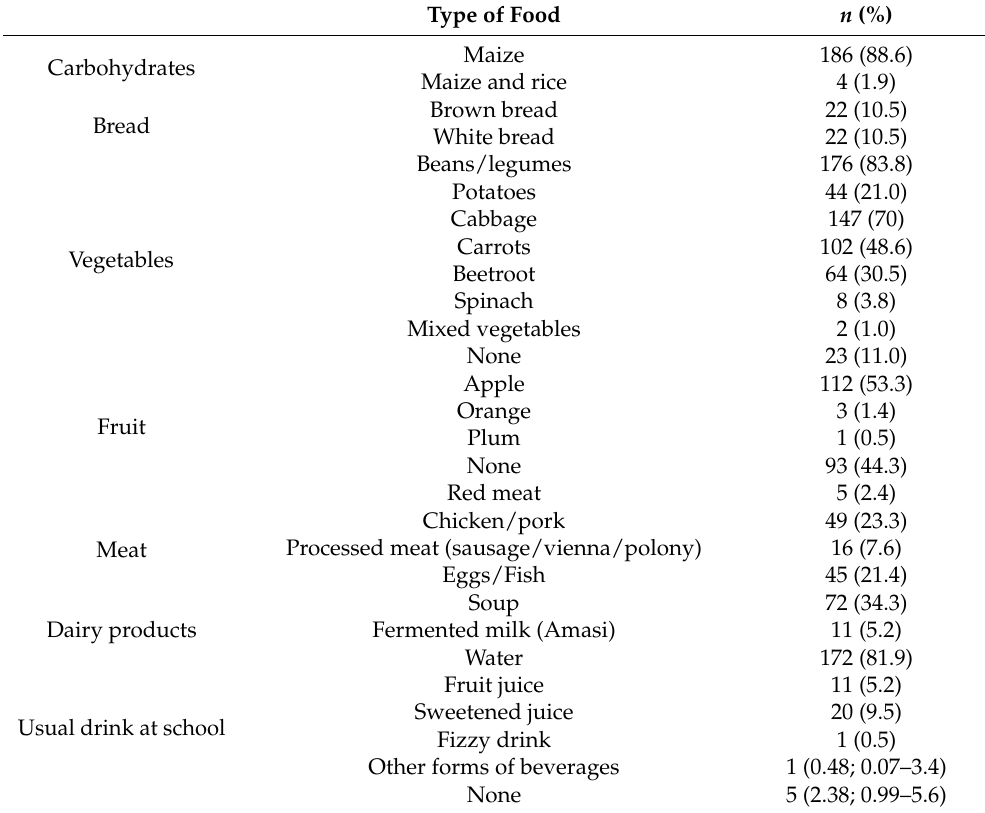
Figure 1. Items commonly purchased from school vendors and/or tuckshop. Table 4. Foods eaten by children and adolescents during lunch served at